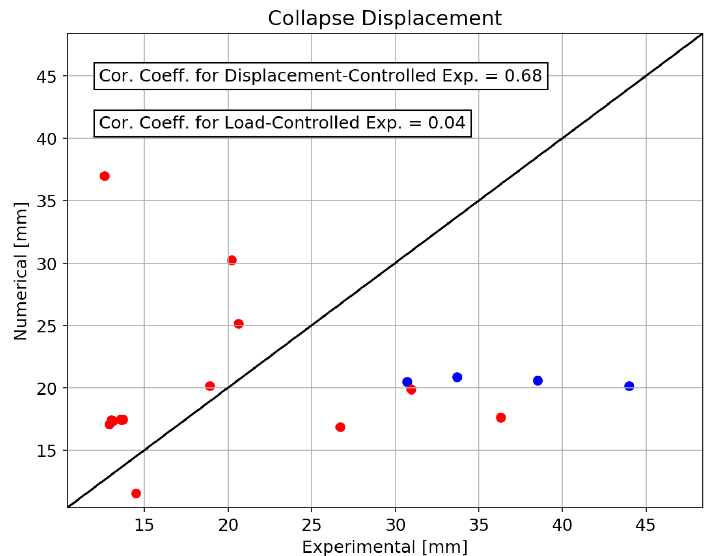
Figure 10. Comparison between numerical and experimental results of displacement-controlled experiments regarding collapse displacement. Red dots mark load-controlled experiments. Blue dots mark displacement-controlled